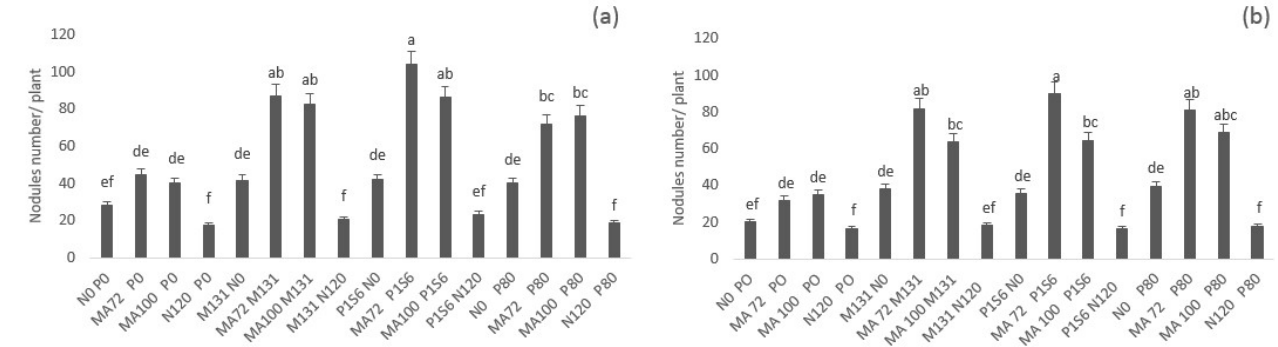
Figure 1. Effect of co-inoculation with Mesorhizobium spp. (MA72 or MA100) and Bacillus sp. (M131) or E. aerogenes (P1S6) and phosphate application combined to rhizobial inoculation on the number of nodules of chickpea in Merchouch ( a ) and Ain Sbit ( b ) sites. Bars followed by the same letter are not significantly different at α = 0.05. (P80 indicate application of 80 kg P2O5/ha, N120 indicate application of 120 kg N /ha, N0 and P0 indicate no nitrogen and phosphate fertilizers applica- tion).